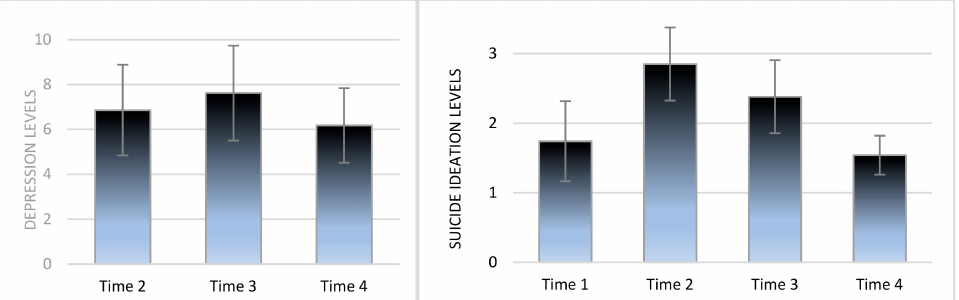
Figure 1. Depression and suicide ideation levels over time among suicide-loss survivors ( N = 152).